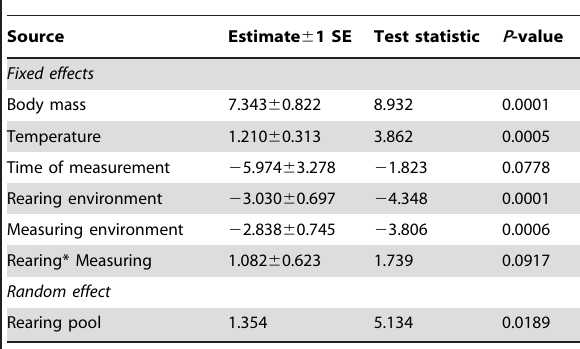
Table 1. Mixed-effects model testing for the influence of body mass, temperature, time of day, rearing environment, and measuring environment on oxygen consumption of